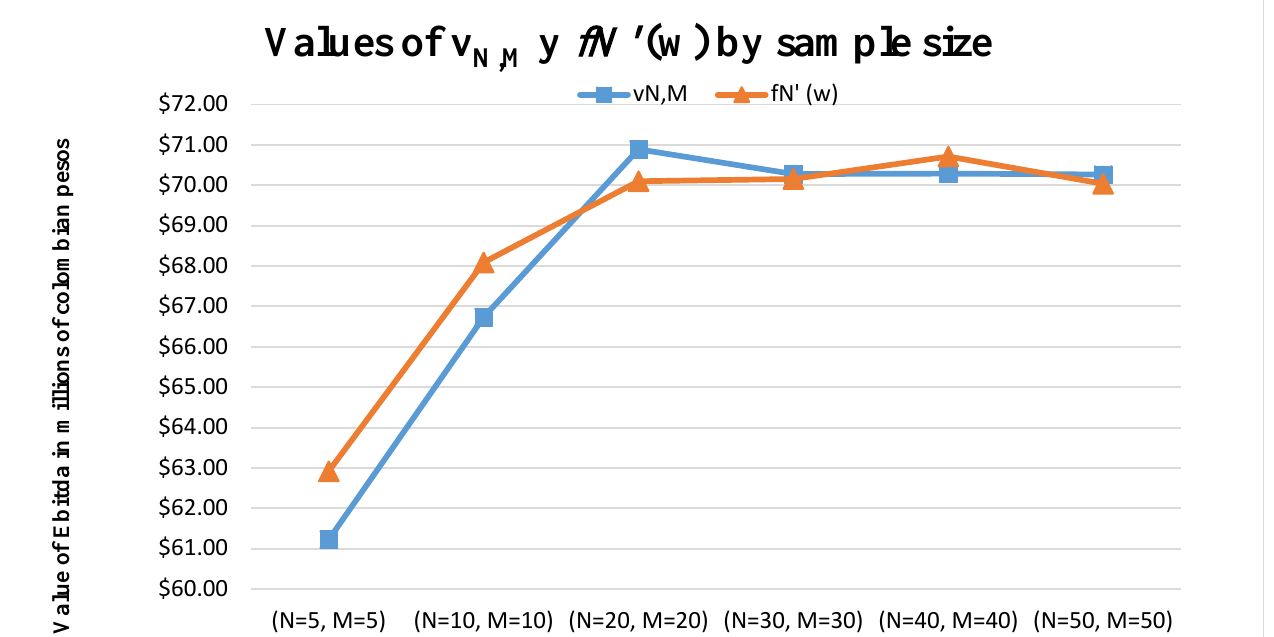
and . In this way the convergence of the proposed 𝑓𝑓̃ 𝑁𝑁 ´ ( 𝑤𝑤 ) 𝜐𝜐 𝑁𝑁 , 𝑀𝑀